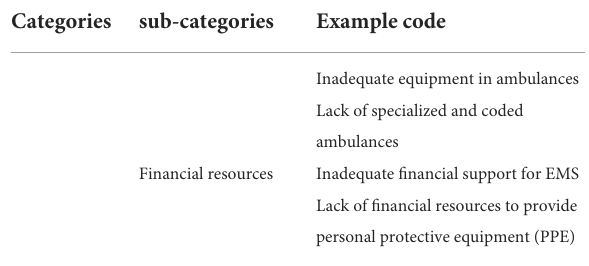
TABLE 3 The Categories, sub-categories and codes extracted from the